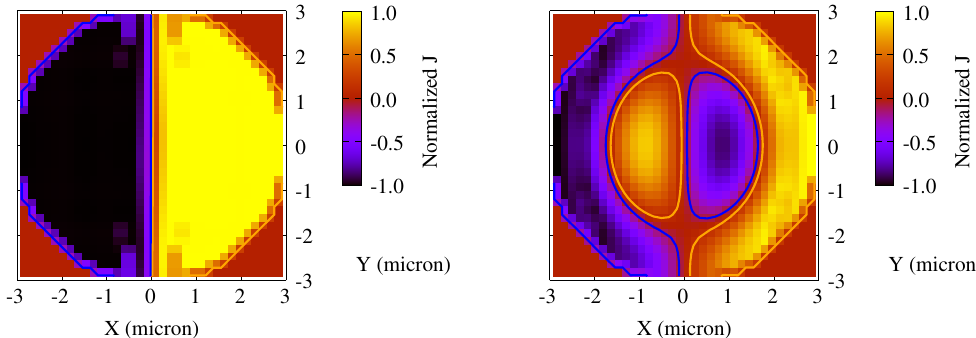
FIG. 4. Distribution of the current density in a NbTi filament at the end of two cycles. Left: the conventional cycle. Right: the demagnetization cycle. The current density is normalized to the J of the NbTi conductor at 5 T, 4.2 K [27]. Contour lines are for þ 0 . 1 c (orange) and − 0 . 1 (blue) of the normalized current density.